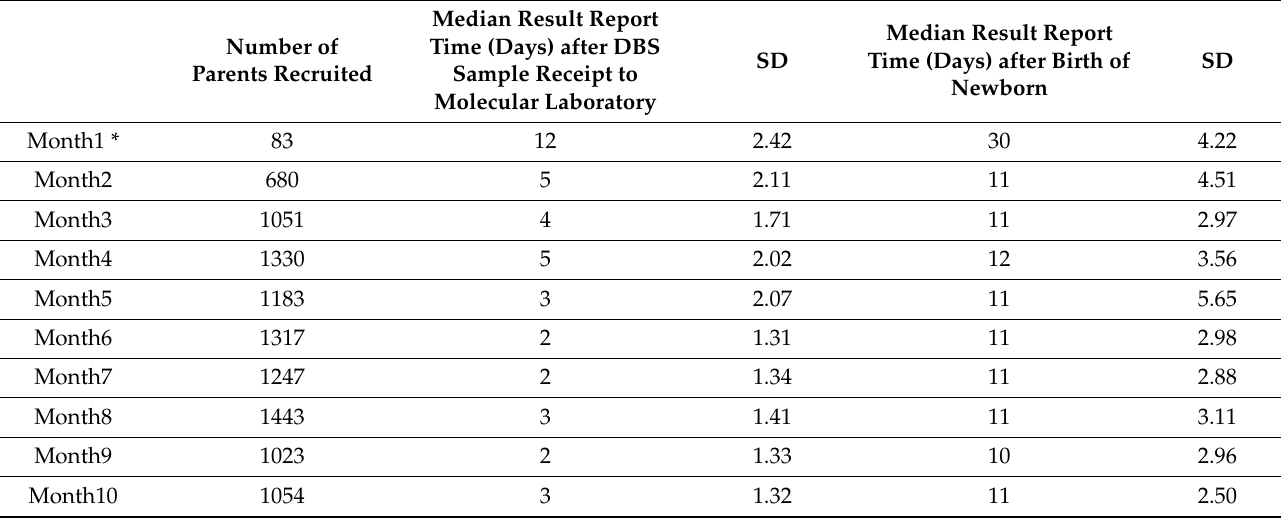
Table 1. Month by month data on parent recruitment and median result report time after DBS sample receipt and birth of